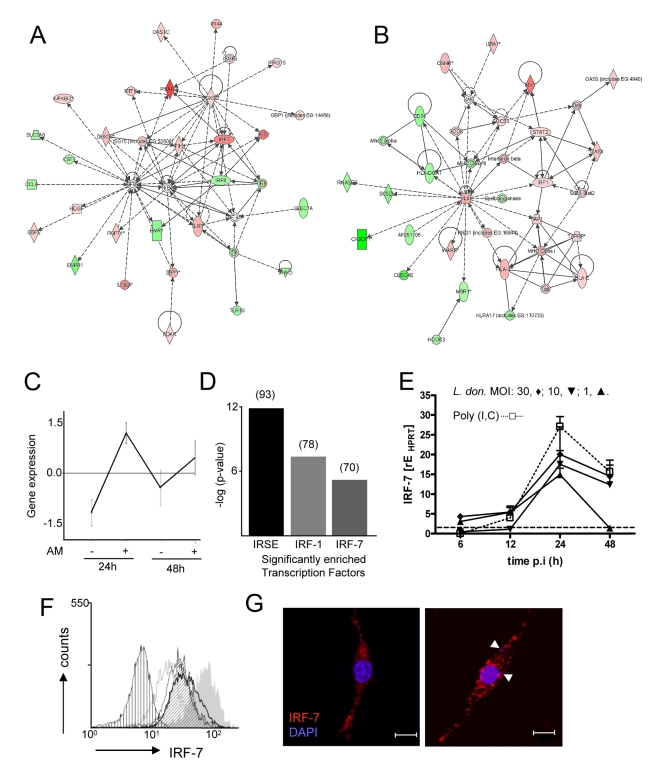
Induction of an interferon-response signature in 14M1.4 cells following L. donovani infection.Expression profiling of 14M1.4 cells, with and without infection with L. donovani was performed using Affymetrix gene array. (A and B) Networks showing up (red) and down (green) regulated genes 48h after L. donovani infection were generated using Ingenuity Pathways; (A) ‘antimicrobial response’ and (B) ‘antigen presentation’. (C) Differentially expressed genes were clustered using CLICK. 550 genes were significantly induced at both 12h and 48h p.i. (D) Transcription factor enrichment analysis using PRIMA identified IRF-7, IRF-1 and ISRE as significantly enriched in the 550 gene cluster shown in (C). Number of genes in each set is indicated in brackets. (E) Real-time RT-PCR showing Irf-7 mRNA accumulation in 14M1.4 following exposure to L. donovani at MOI of 30∶1 (diamond), 10∶1 (invert triangle), 1∶1 (triangle) or after exposure to 100µg/ml poly(I:C) (open square) . (F) Kinetics of IRF-7 expression on 14M1.4 cells following exposure to L. donovani at a MOI of 10∶1 for 6 (open grey line), 12 (open thin black line), 24h (open thick black line) or 48h (angled hatch) or to 100µg/ml poly (I:C) (filled gray). Control untreated cells are also shown (vertical hatch) (G) Expression of IRF-7 by confocal microscopy (red, IRF-7; blue, DAPI) in uninfected (left) and L. donovani- infected (right) 14M1.4 cells. Amastigotes are indicated by arrowheads. Scale bar: 10µm.